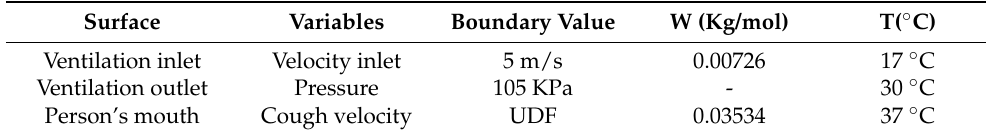
Table 1. Boundary conditions of continuous air flow phase